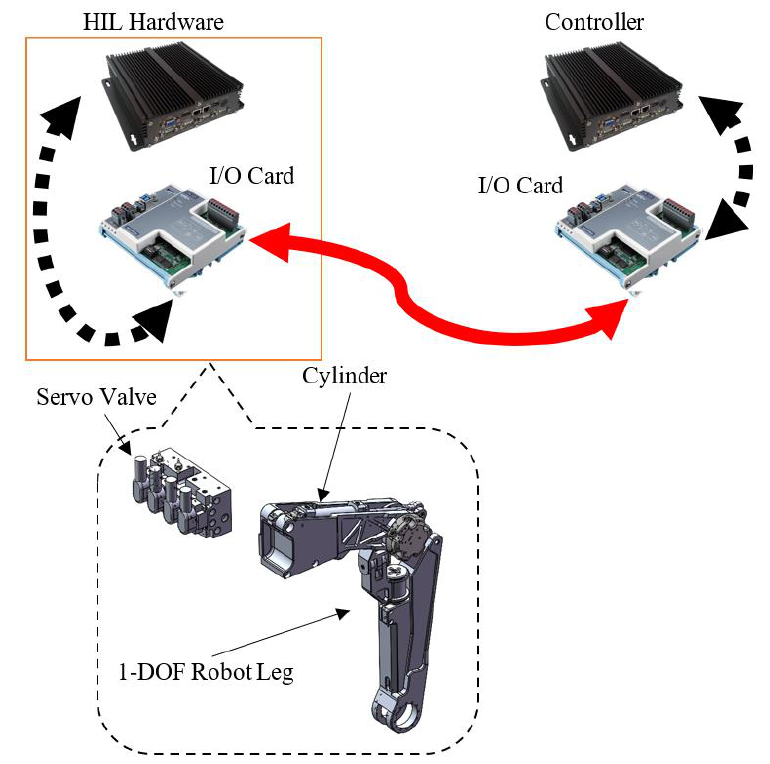
Figure 6. Replacement of a hydraulic servo system with HIL hardware.